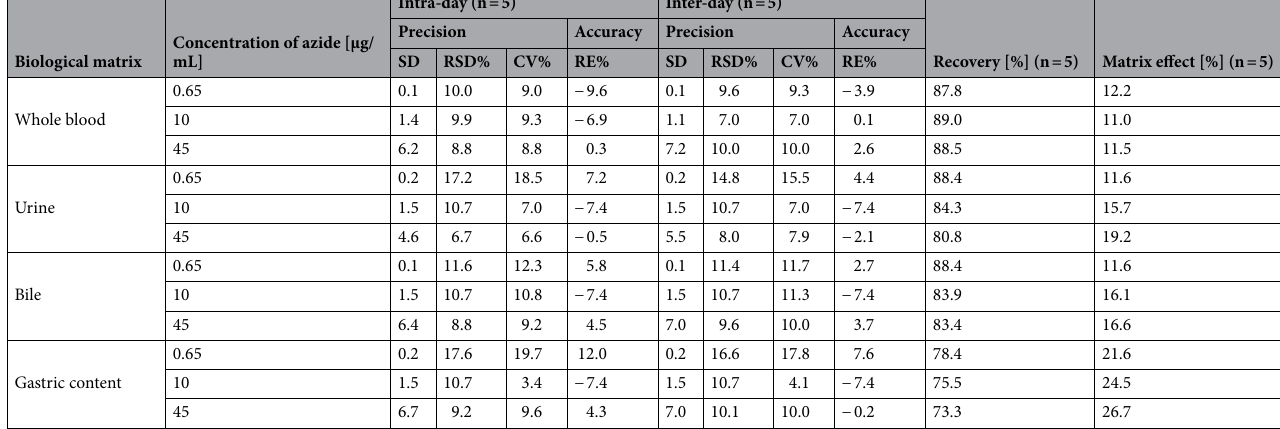
Table 2. Validation results for various biological matrix. SD standard deviation, RSD% relative standard deviation, CV% coefficient of variation, RE%